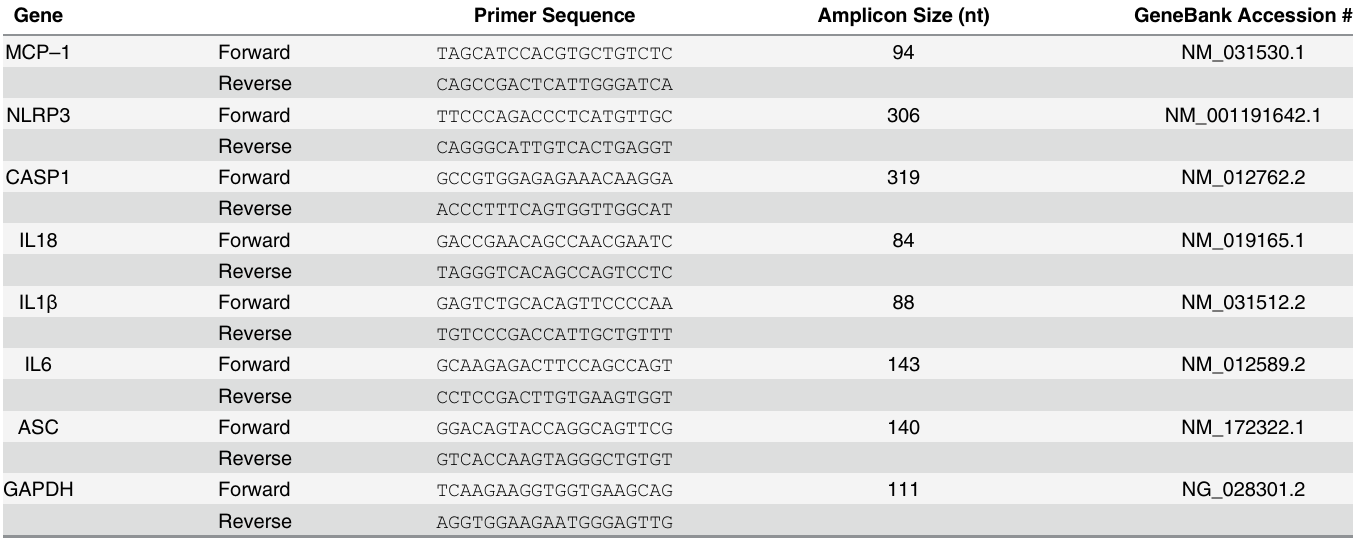
Table 1. Gene specific primers for qRT-PCR